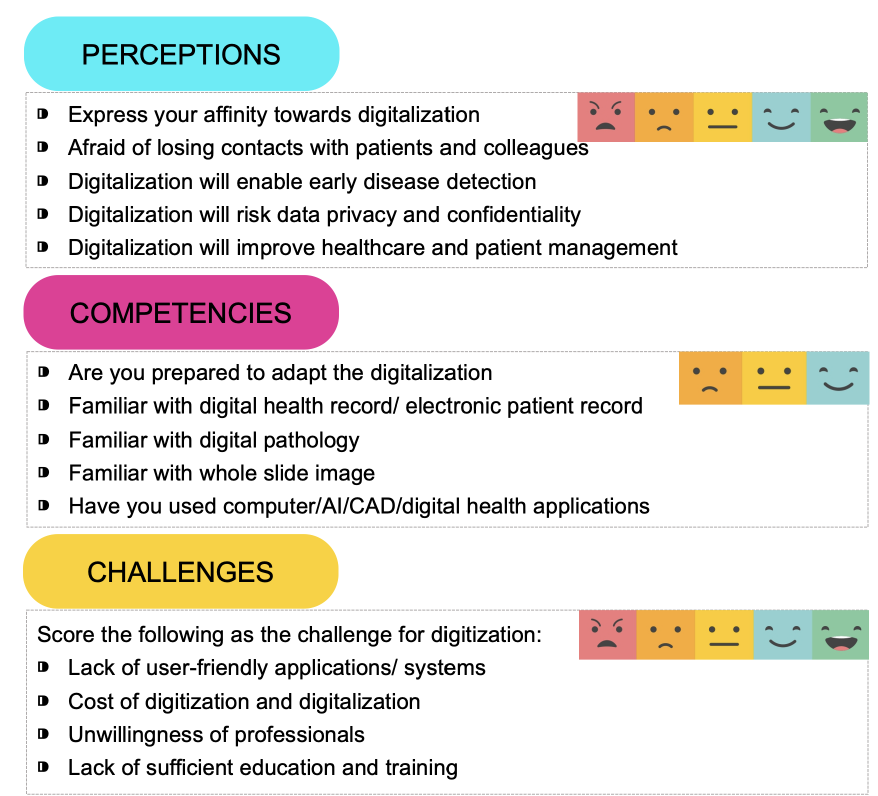
Figure 1. Example of questions designed to gather responses on three different